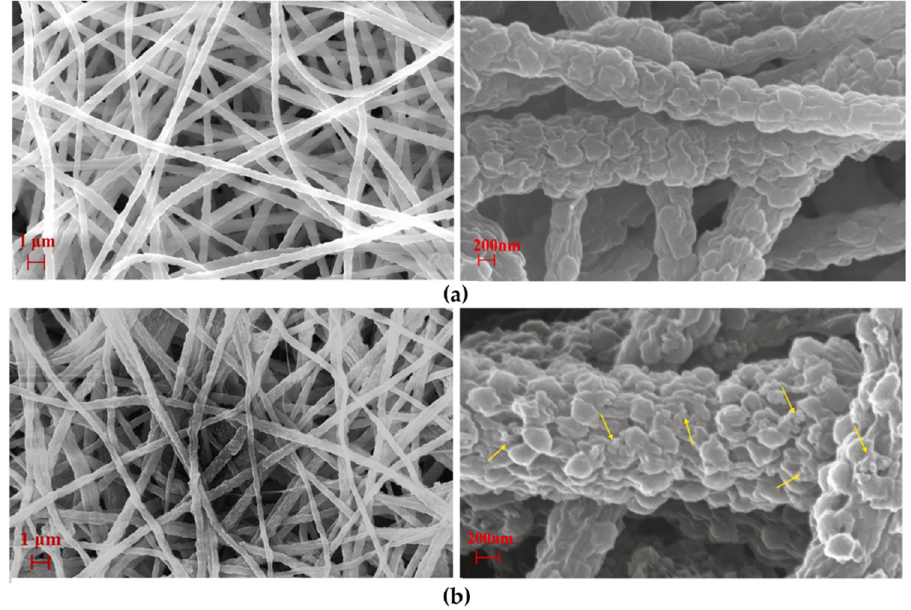
Figure 14. SEM of ( a ) PVDF electrospun nanofibers and ( b ) PVDF-TCN-2g electrospun nanofibers (arrows point to catalysis). With different magnification. (Reprinted from the work of Zheng et al. [44]. Copyright 2021, with permission from Elsevier).